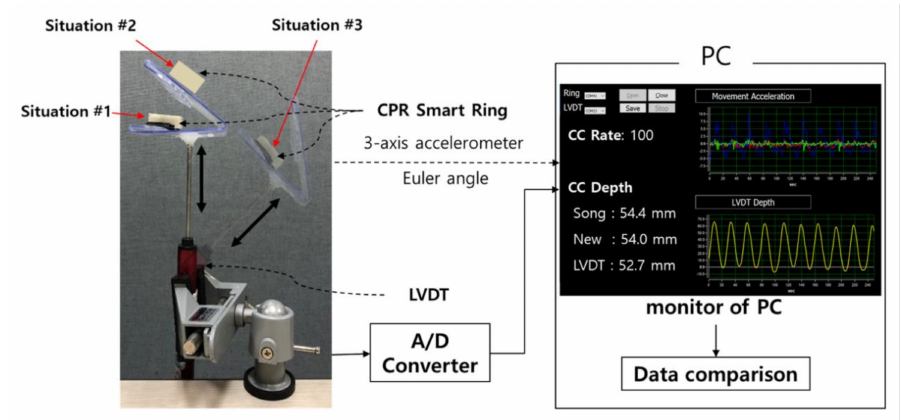
Figure 5. Experimental settings to evaluate the accuracy of the proposed depth feedback system.